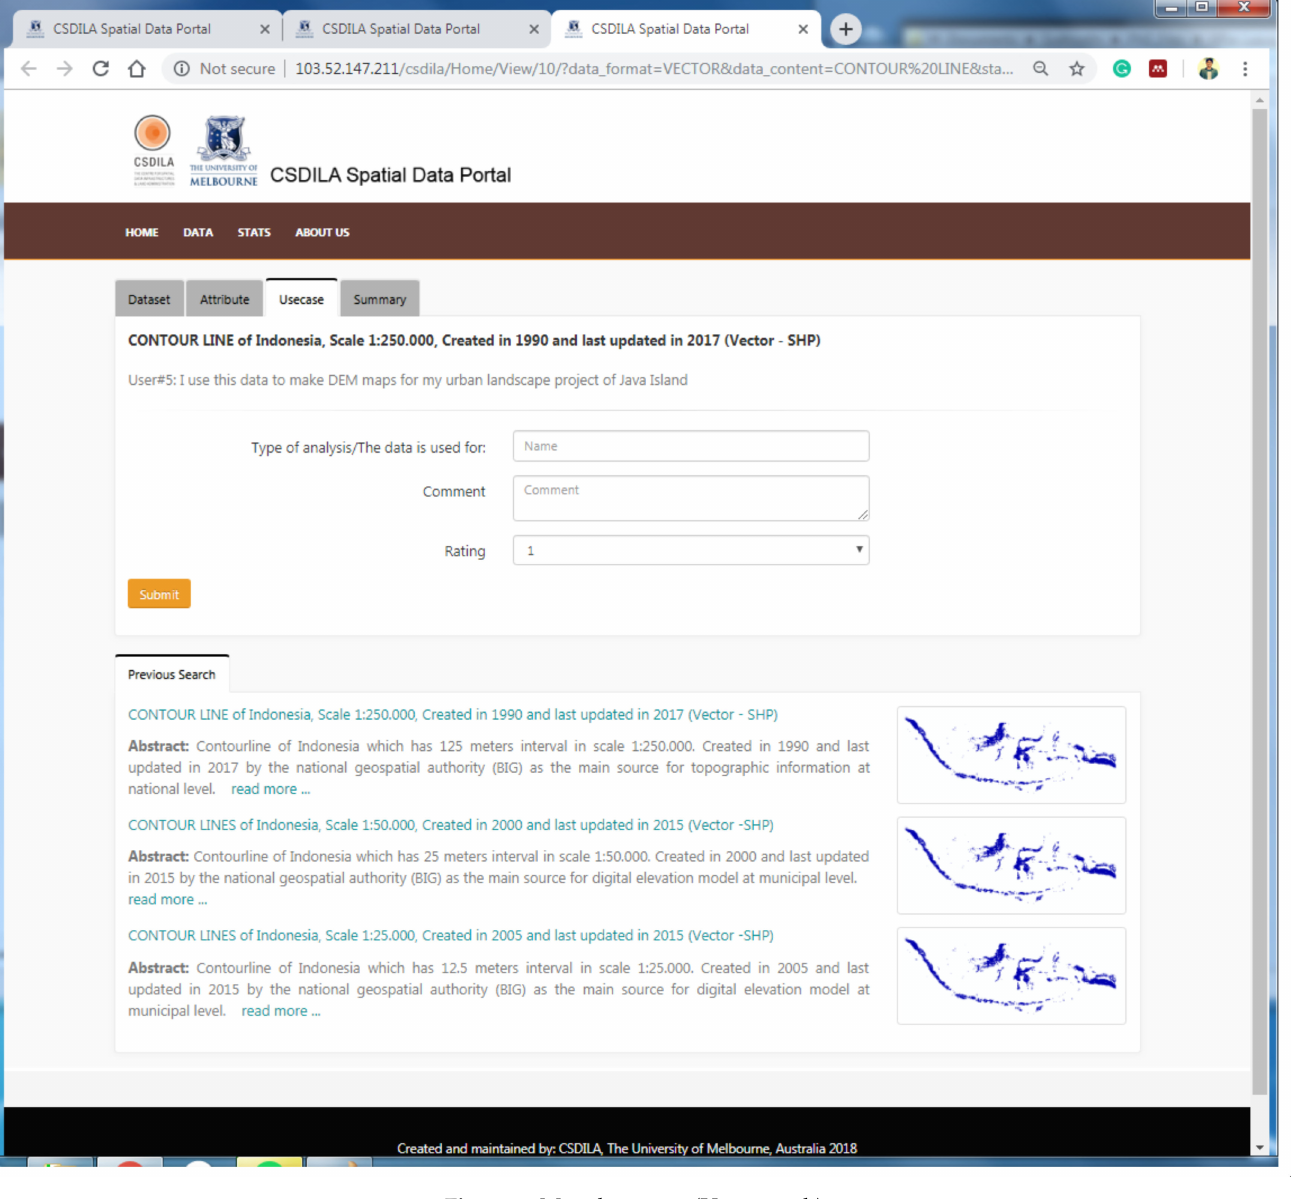
Figure 8. Metadata page (Usecase